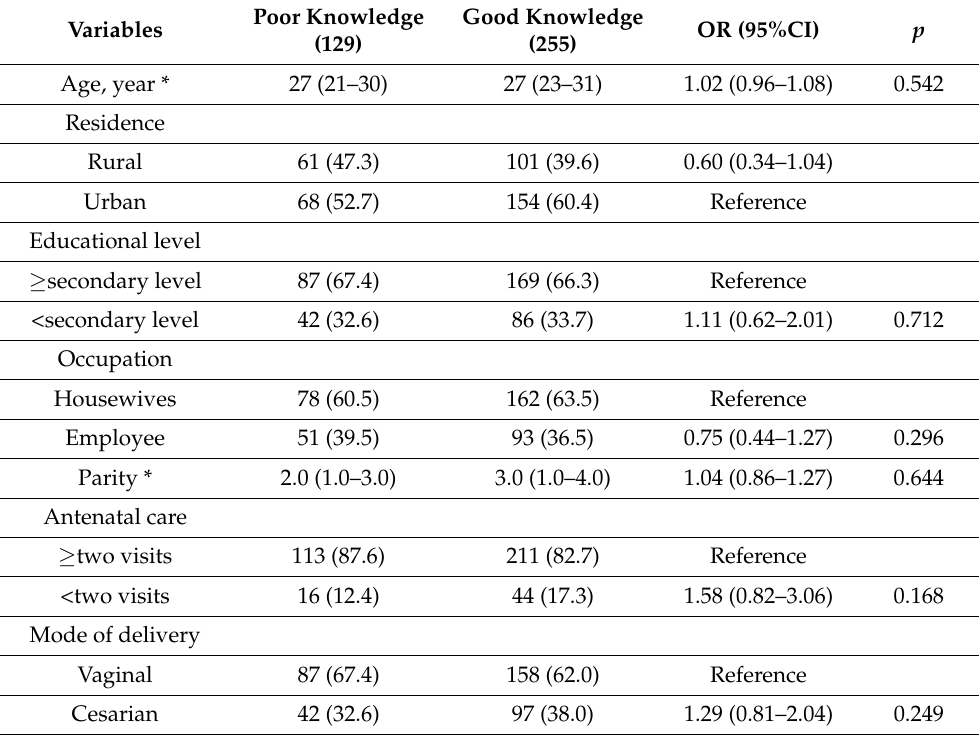
Table 3. Factors associated with participants’ knowledge of ENC.